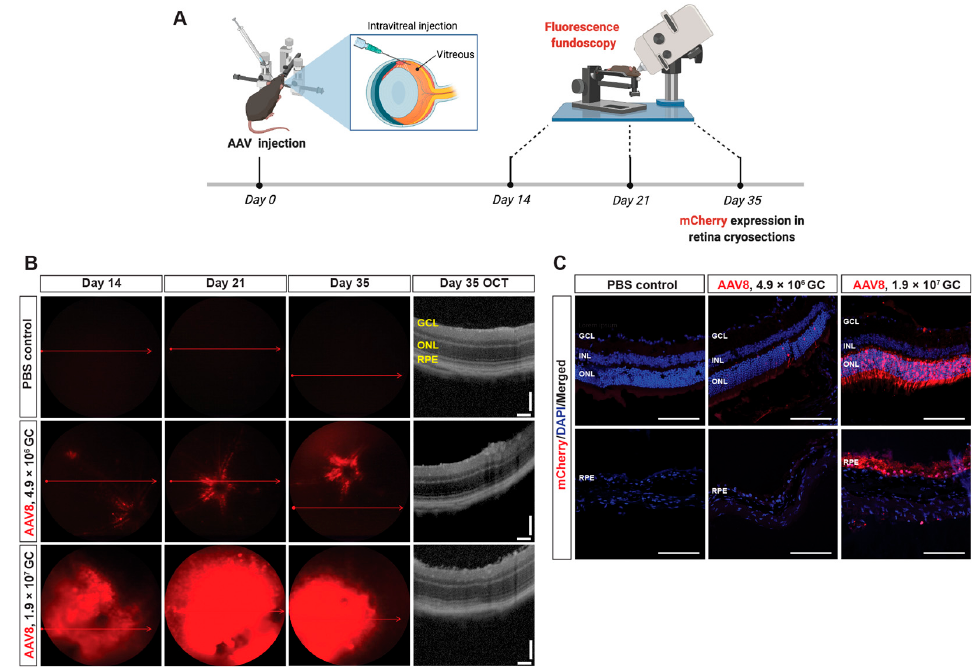
Figure 5. In vivo transduction of AAV8 in murine retina. ( A ) Study design and experimental timeline used to assess in vivo efficacy of AAV8- Ephx2 shRNA. Noninvasive fluorescence fundoscopy was used to assess mCherry expression in vivo on day 14, 21, and 35 post-injection, followed by cryosection imaging ex vivo. ( B ) Time-dependent and viral dose-dependent transduction efficiency. Fluorescence fundoscopy showing in vivo mCherry expression in wide view image of retina (red lines indicating OCT scan positions) and corresponding OCT images on day 35 showing no sub- stantial changes in retinal structure. ( C ) AAV transduction visualized in retinal sections five weeks after injection. Retinal sections showing mCherry positive cells (red) in ONL and RPE. Nuclei (DAPI) are blue. GC, genome copies. Scale bars = 100 μ m.